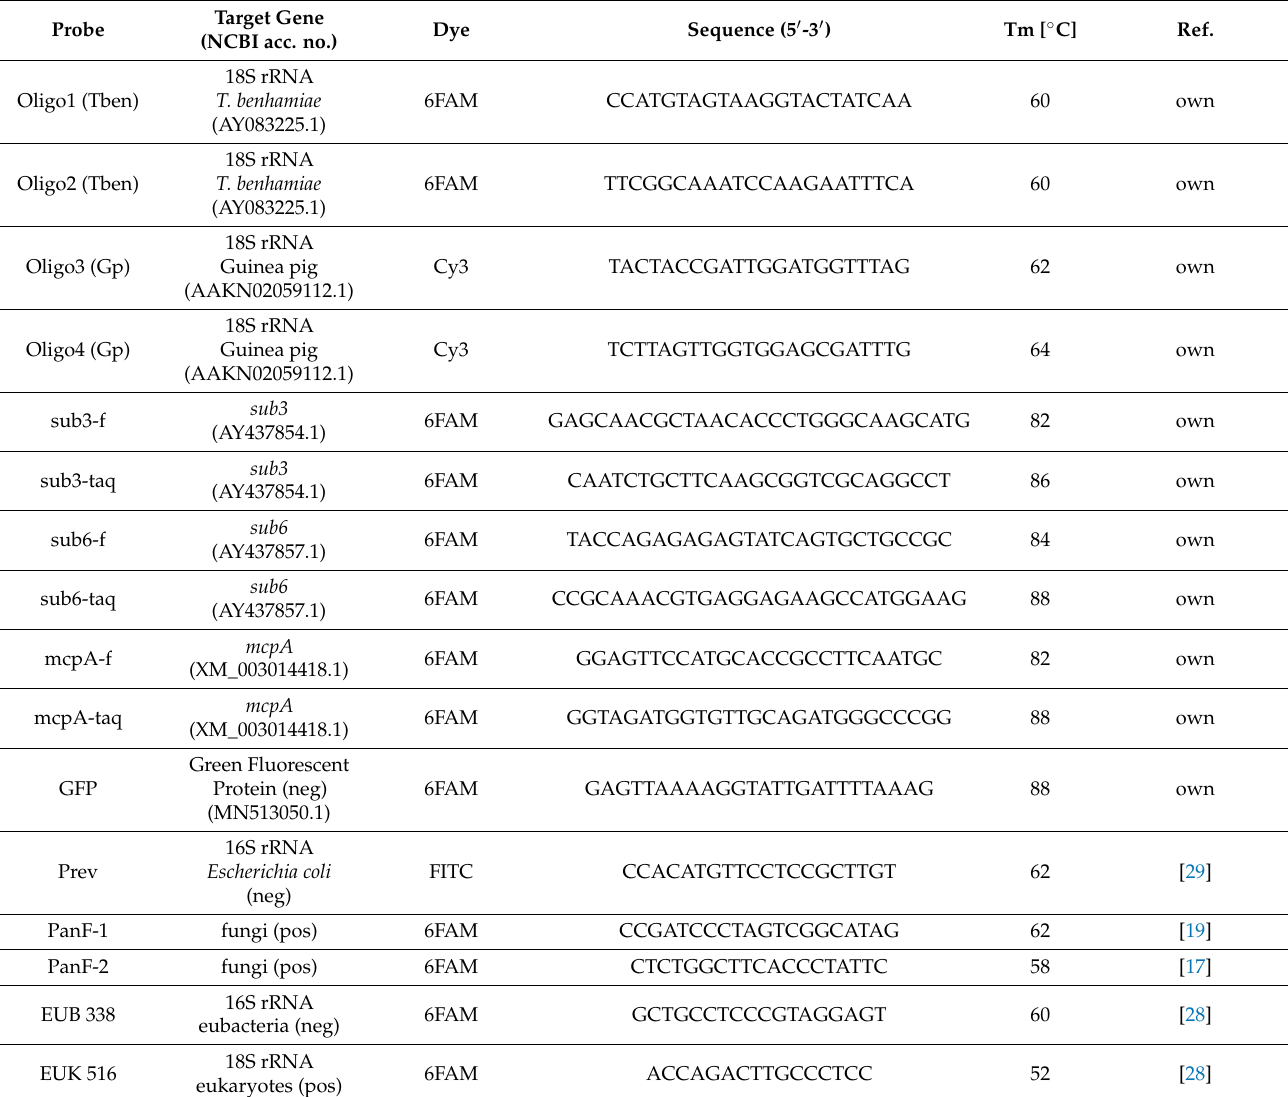
Table 1. Name, sequence and further information about the probes used for